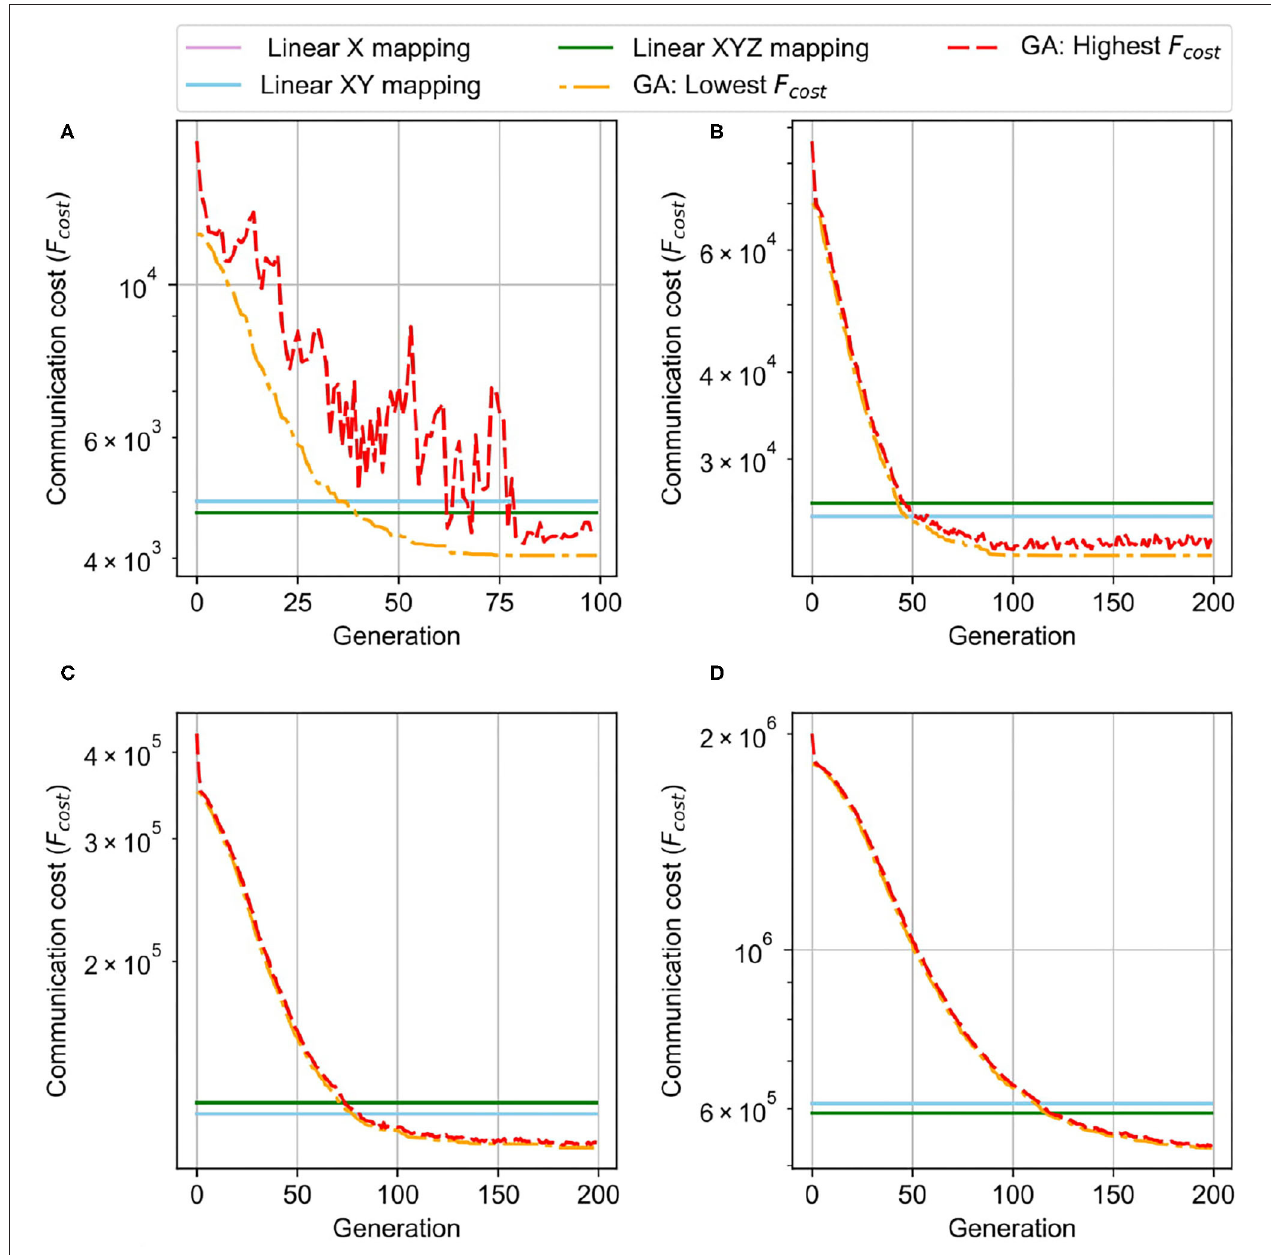
Figure 14 . We keep the same node size as 256 neurons per node for a fair comparison and the change between the NoC sizes. We compare 3D and 2D networks with the same number of nodes (64, 128, 256, and